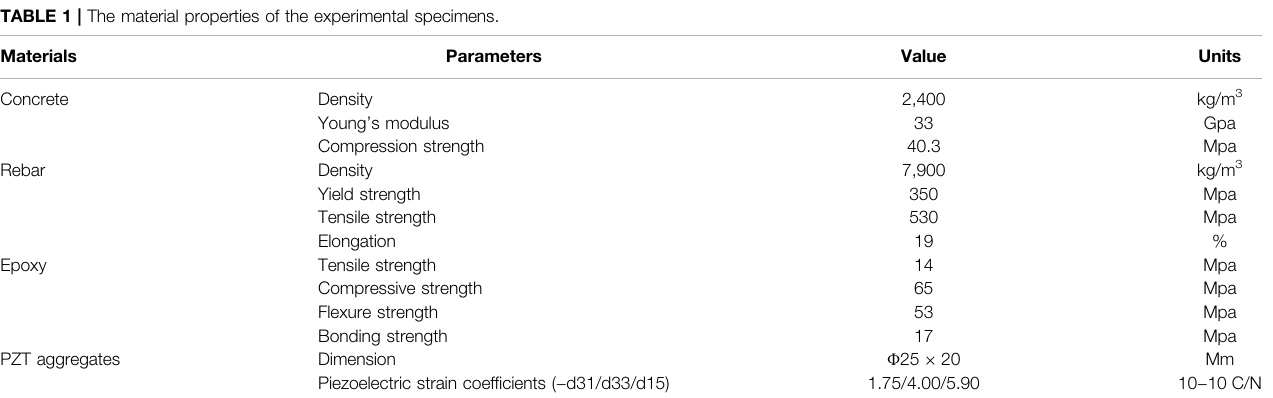
TABLE 1 | The material properties of the experimental